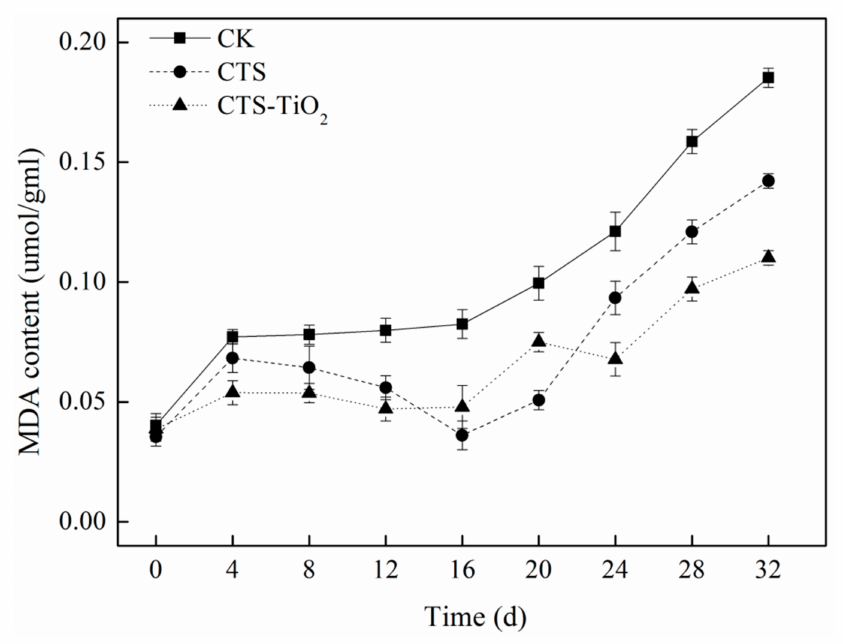
Figure 3. Effects of different treatments on MDA of blueberry fruit during 32 days of storage at 0 ◦